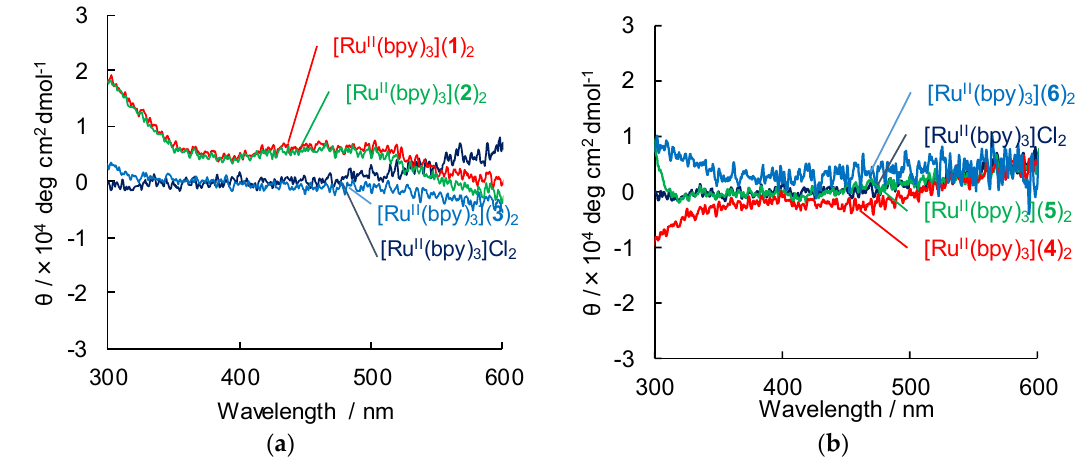
Figure 4. Circular dichroism (CD) spectra of [Ru II (bpy) 3 ](lipid) 2 (Lipid = 1 – 3 ( a ), 4 – 6 ( b )) in EtOH at 293 K. [Ru II (bpy) 3 ](lipid) 2 = 0.1 mM. Path length: 1 cm.